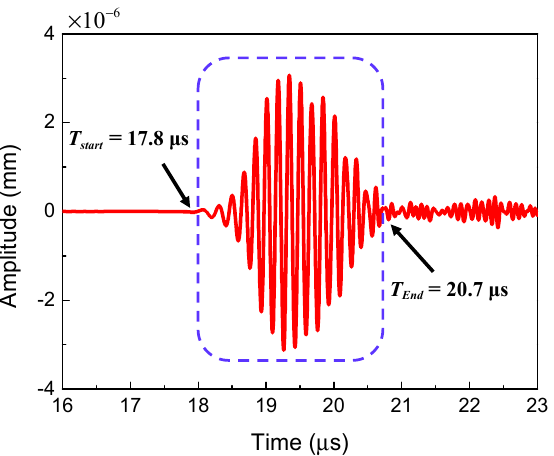
Figure 12. Time-domain signal of the resonant wave for locating the micro-crack region ( c = 0.00625, f R = 6 MHz, µ = 0.3, L 1 = 35 mm, L 2 = 10 mm).